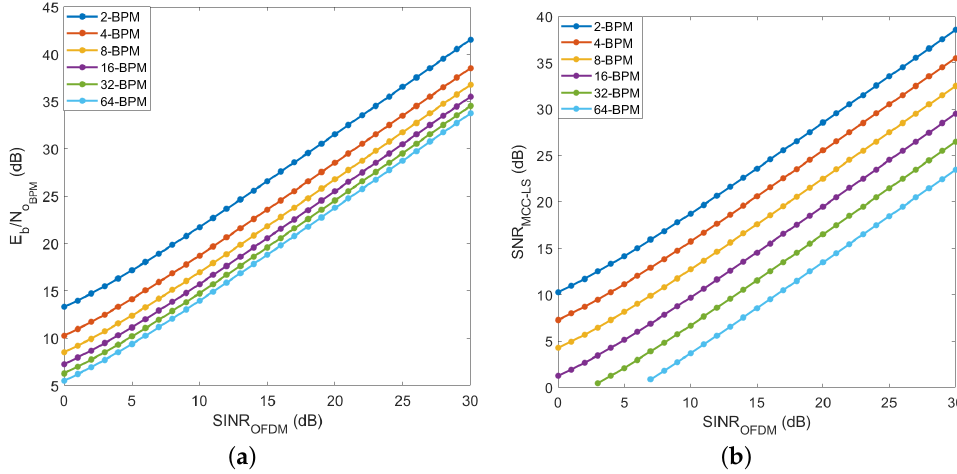
Figure 8. Power requirements by MCC for embedding BPM with respect to SINR OFDM